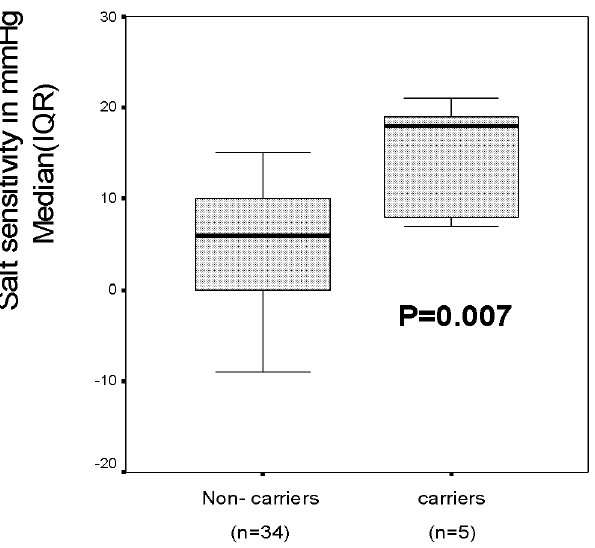
Figure 1. Salt induced change in 24 hour systolic ABP (salt sensitivity) in the carriers of the rs4149601 GG-genotype together with the rs2288774 CC-genotype vs. all other genotype combina- tions. Box plot presented as median and inter quartile range.